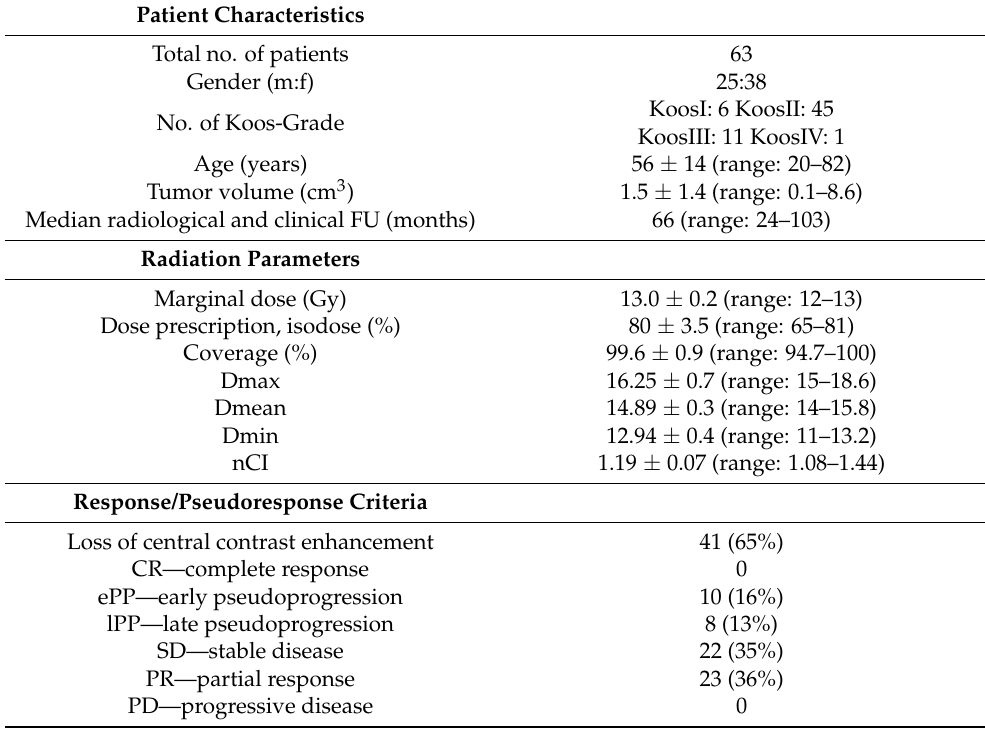
Table 2. Patient and treatment characteristics, clinical data and response criteria of the observed cohort after Cyberknife ® SRS. Unless mentioned otherwise, data are presented as mean with SD and range in